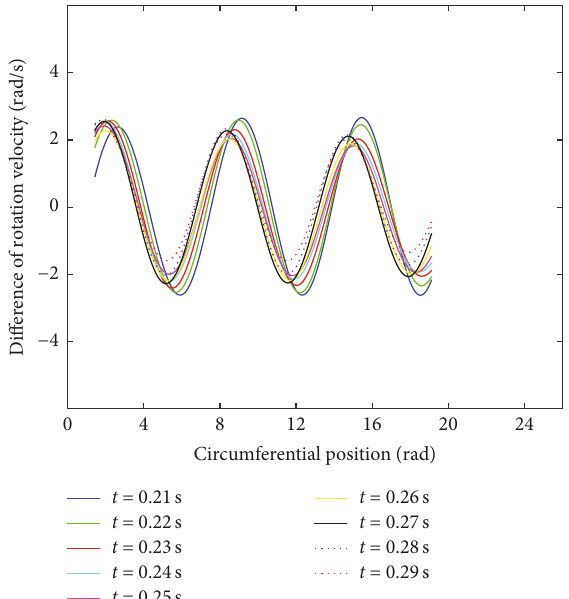
Figure 25: The relative rotation velocity of each node at different moment.